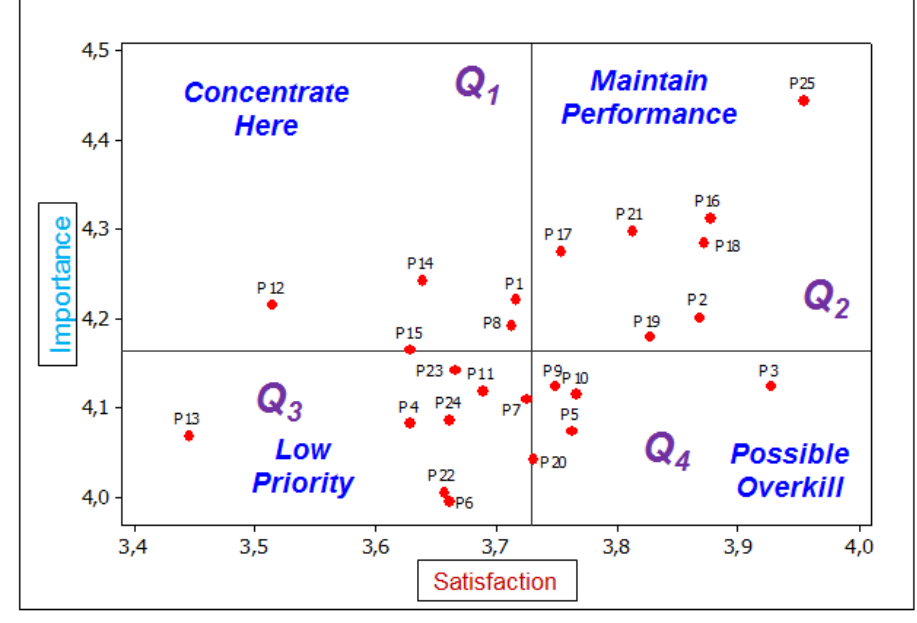
Figure 3 The IPA chart of the